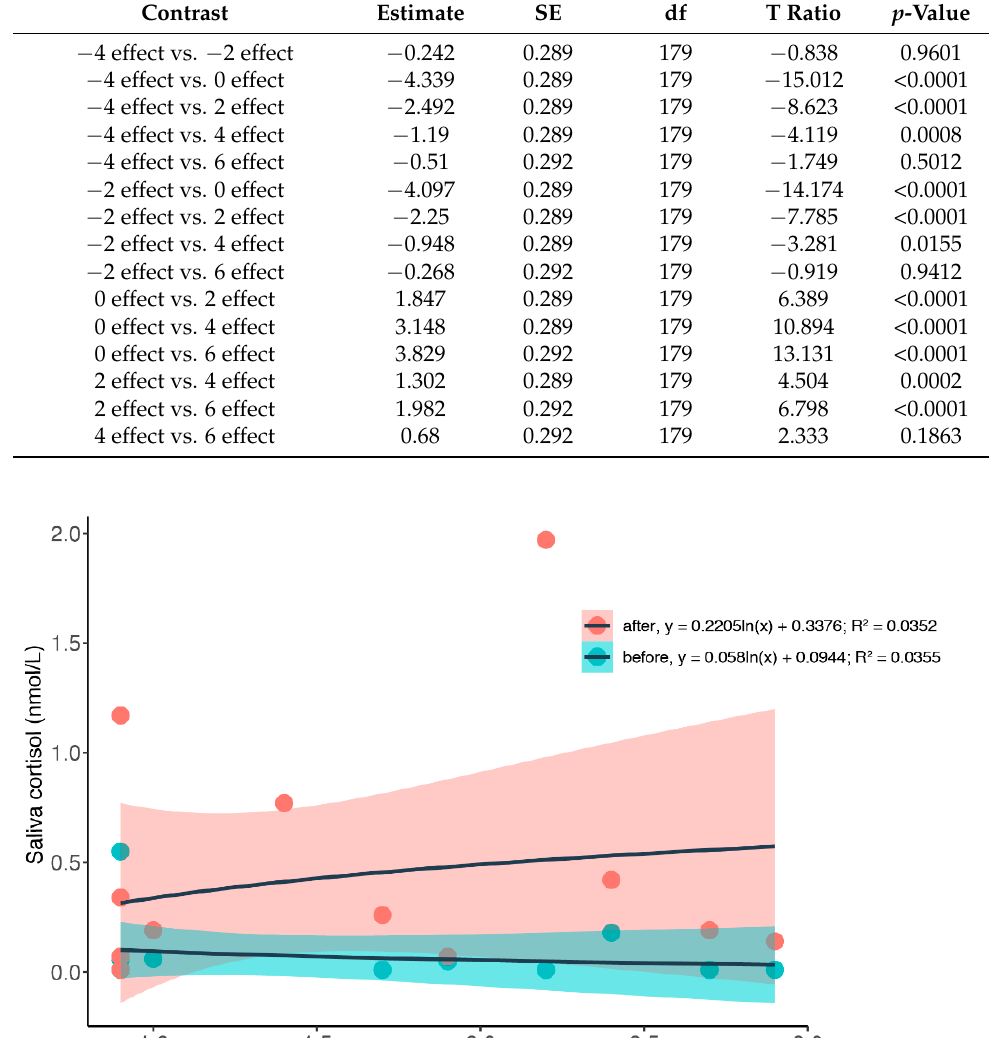
Table A3. Tukey’s pairwise post hoc comparisons for feeding experiment II; see Figure 9.